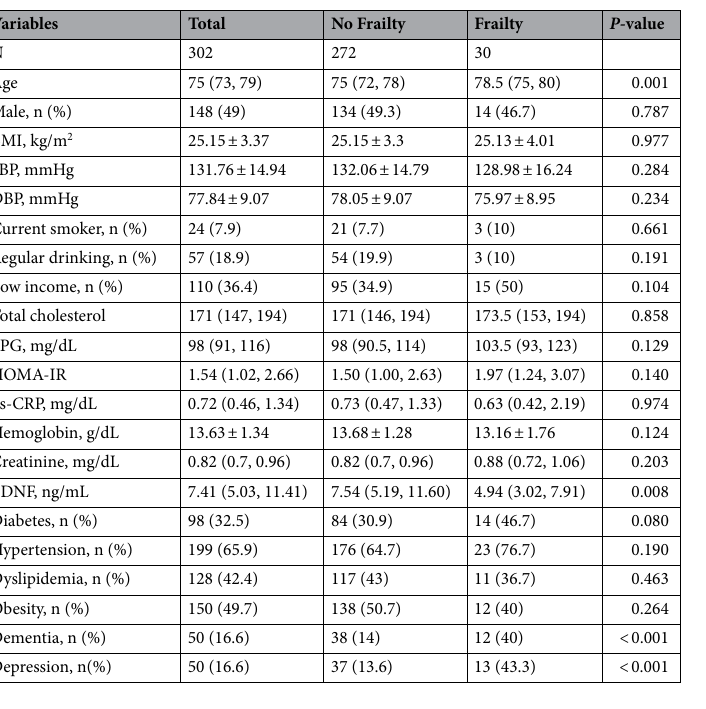
Table 1. Baseline characteristics of study population according to the presence of frailty. Data are expressed as percentage or as mean (IQR) or mean ± SD, unless otherwise noted. Groups were compared using χ 2 test for categorical variables and independent two-sample t-test or Mann-Whiney U-test for continuous variables after log-transformation of skewed variables including plasma BDNF. BDNF, brain-derived neurotrophic factor; BMI, body mass index; DBP, diastolic blood pressure; FPG, fasting plasma glucose; HOMA-IR, homeostasis model assessment-insulin resistance; hs-CRP, high-sensitivity C-reactive protein; SBP, systolic blood pressure.